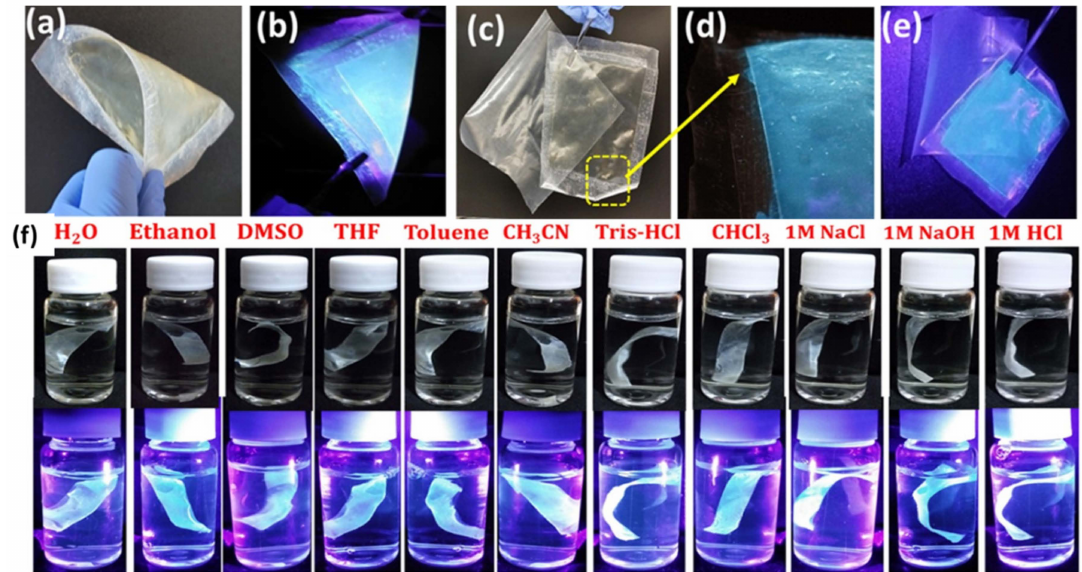
Figure 3. CDs-coated polypropylene film twisted in ( a ) daylight and ( b ) under UV light ( c ), com- parative images of coated and noncoated films, ( d ) magnified image of ( c , e ) coated and noncoated films under UV irradiation, ( f ) coated films in different solvents and their daylight and UV irradiated images. Reproduced with permission from ref.